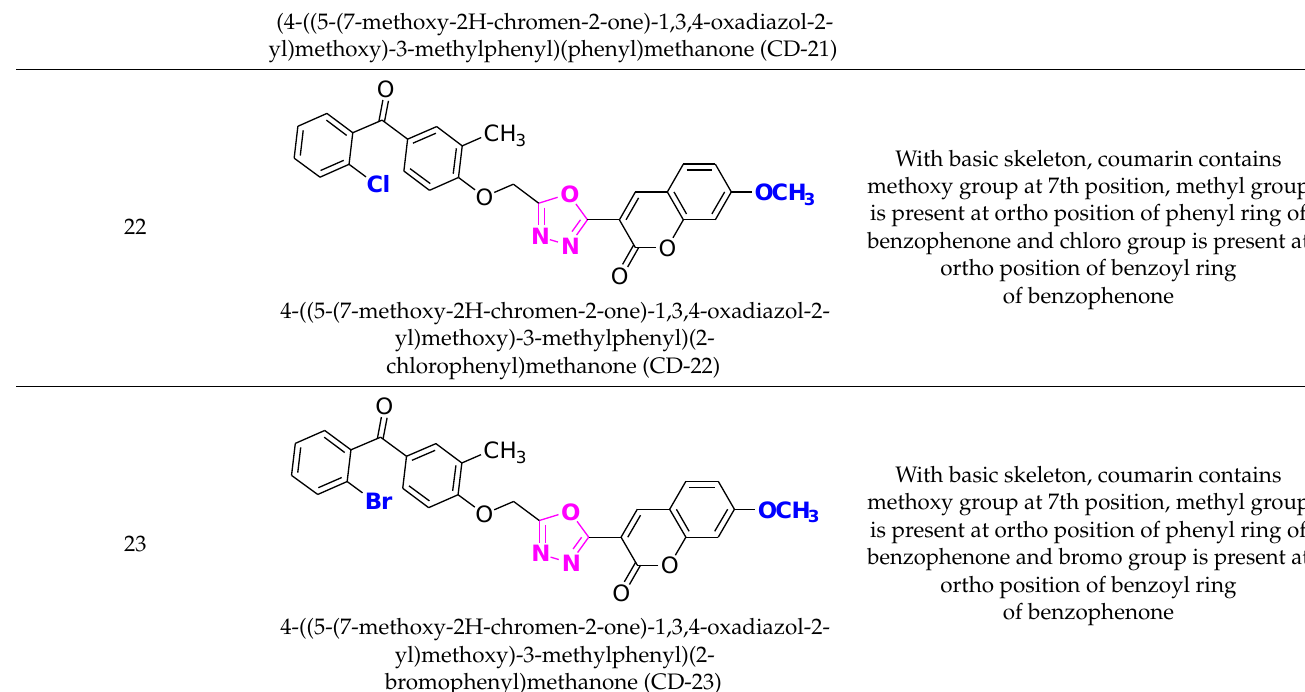
With basic skeleton, coumarin contains methoxy group at 7th position, methyl group is present at ortho position